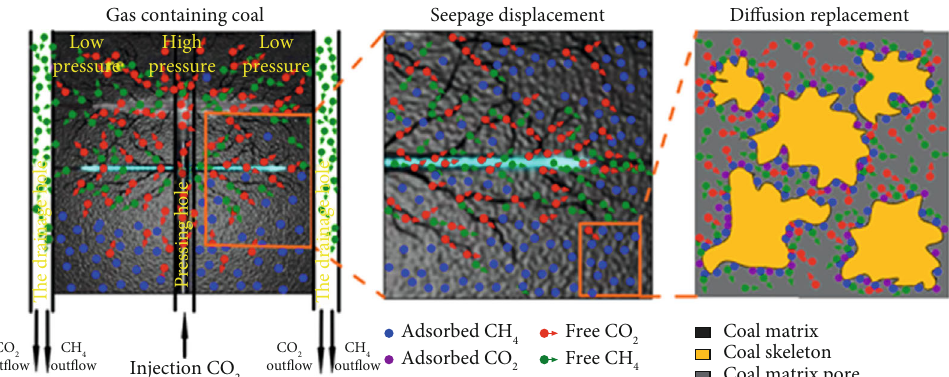
Figure 1: Schematic diagram of coal seam liquid CO